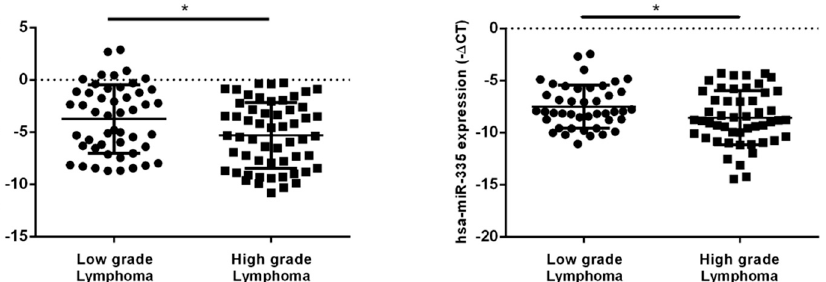
Figure 5. Expression levels of hsa-miR-150-5p and hsa-miR-335-5p in plasma samples of NHL patients’ groups according to lymphoma grade. Hsa-miR-150-5p and hsa-miR-335-5p presented lower plasma levels in patients with high grade lymphoma compared to patients with low grade lymphoma ( p = 0.015 and p = 0.034, respectively). * p < 0.05. The plasma levels of MALAT1 and NEAT1 were higher in patients with high grade lymphoma compared to low grade lymphoma ( p = 0.035 and p = 0.018, respectively) (Figure 6).